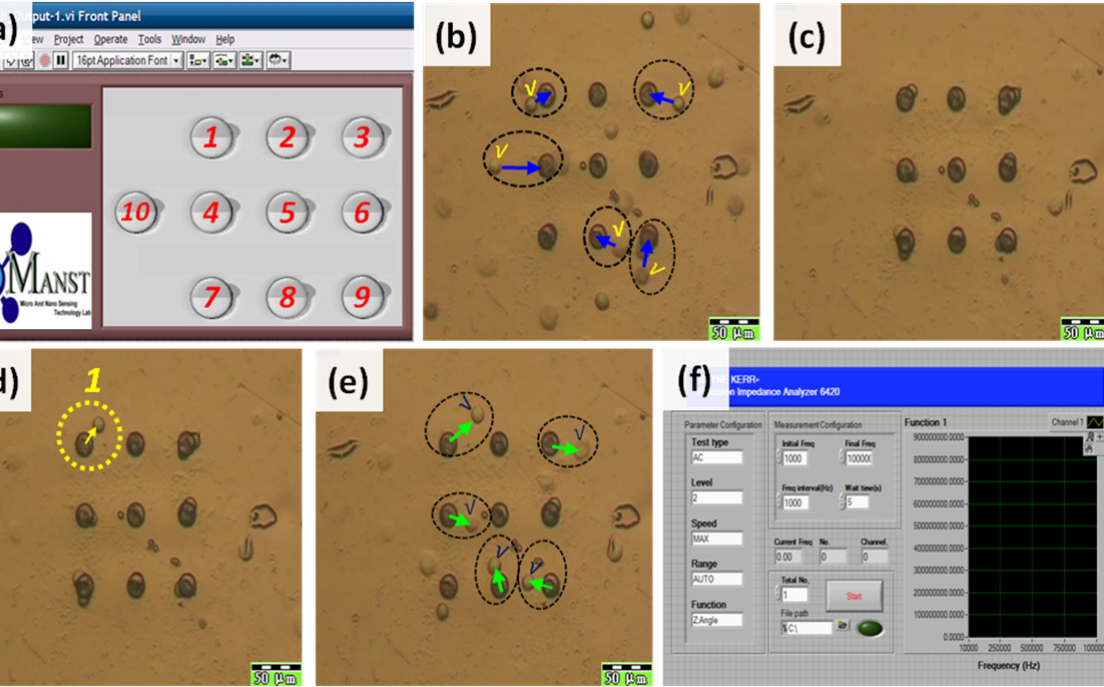
Figure 9. Optical micrographs demonstrating the trapping and programmable releasing of single cells: (a) LabVIEW program for manipulation of cells, (b) cells suspended in the micro-cavity array, (c) trapping cells in the micro-cavity array by switch on No. 10 with an AC signal in the negative-DEP range, (d) show the target (arrow) cell released by switch on No.1 button, (e) all other trapped cells were released by switch on No. 10 button with an AC signal in the positive-DEP frequency range, (f) LabVIEW program for impedance sensing of